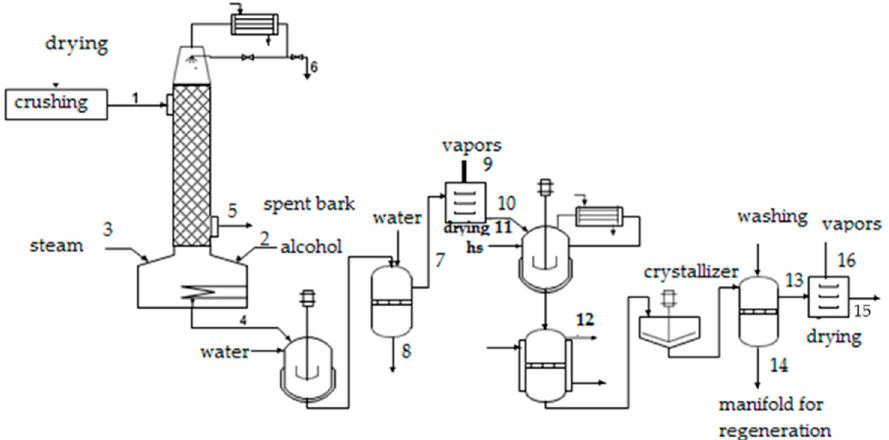
Figure 5. Technological scheme of the betulin production process.